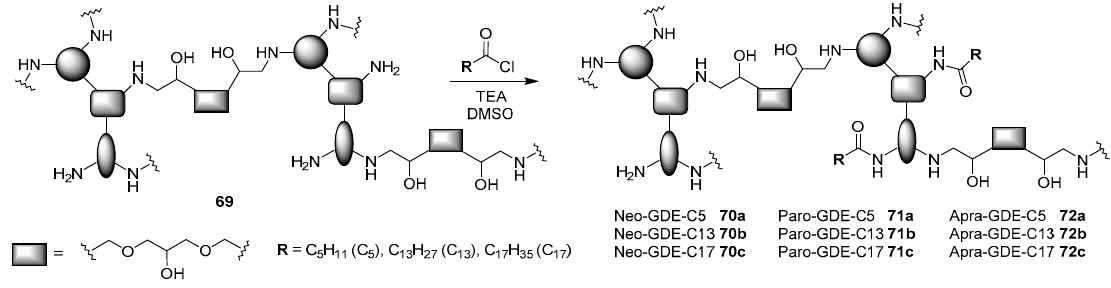
Figure 20. Synthesis of AG-GDE lipophilic polymers 70 – 72 .